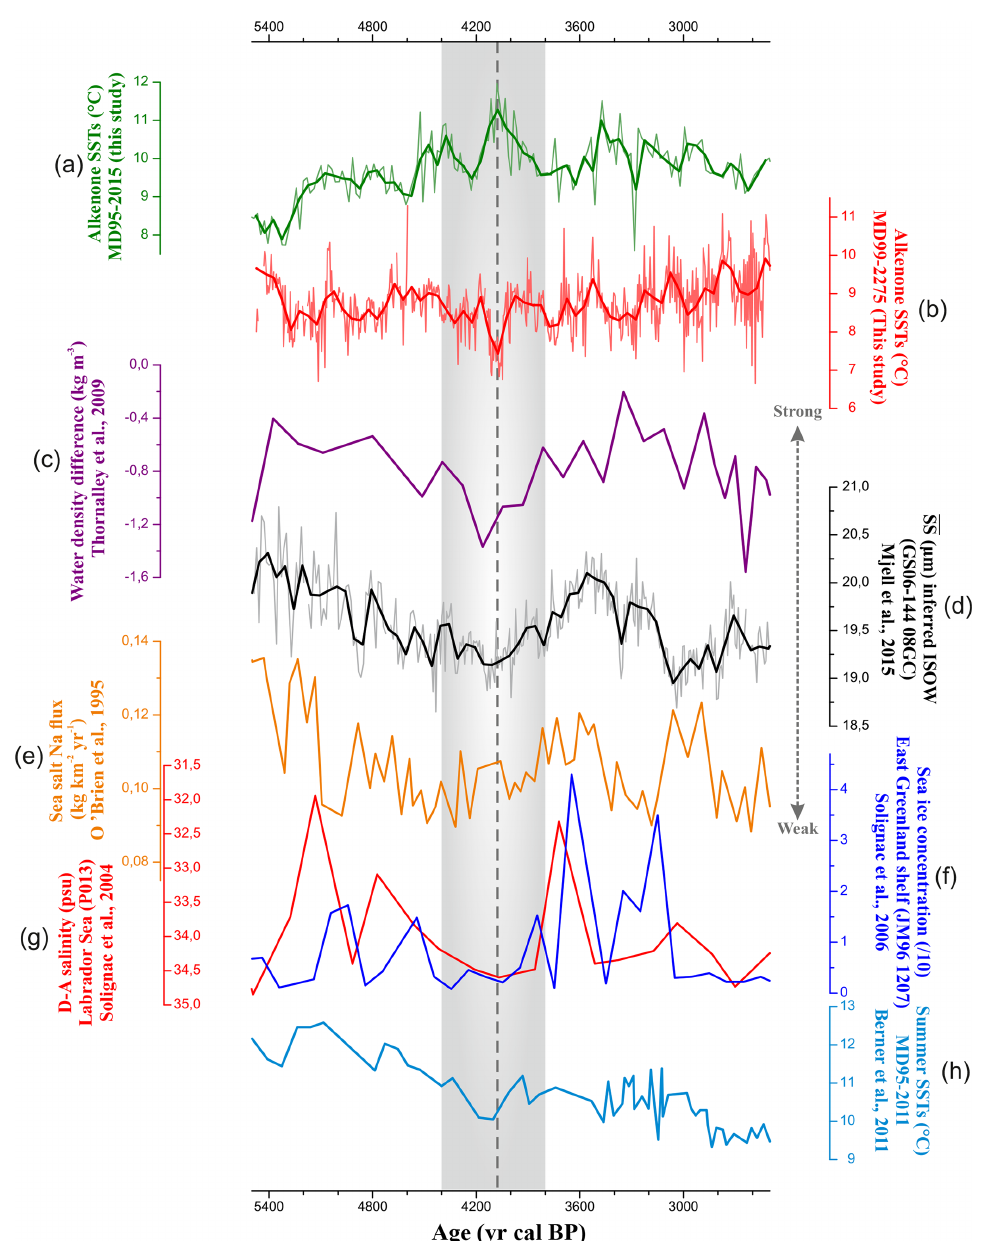
Figure 3. Paleoclimatic and paleo-oceanographic data from the North Atlantic during the 4.2kaBP event. (a) Alkenone-derived SSTs at the MD95-2015 core. (b) Alkenone-derived SSTs at the MD99-2275 core. (c) Density difference between surface and subsurface waters obtained from paired Mg/Ca and δ 18 O in Globigerina bulloides and Globorotalia inflata in core RAPiD-12-1K (site 4 in Fig. 1) (Thornalley et al., 2009). (d) Mean sortable silt (SS, 10–63µm) in core GS06-144 08GC in the Iceland Basin (site 3, Fig. 1) (Mjell et al., 2015). (e) Sea salt Na flux from the GISP2 ice core (site 7, Fig. 1) (O’Brien et al., 1995). (f) Sea ice concentration from the East Greenland shelf based on dinoflagellate cyst assemblages in core JM96 1207 (site 6, Fig. 1) (Solignac et al., 2006). (g) Dinoflagellate cyst-assemblage-inferred sea surface salinity from the Labrador Sea core P-013 (site 5, Fig. 1) (Solignac et al., 2004). (h) Summer SSTs derived from diatom-based weighted averaging partial least squares transfer function from core MD95-2011 (site 9, Fig. 1) (Berner et al., 2011). For panels (a) , (b) and (d) 50-year binning is applied to reduce the effect of proxy reconstruction error (thick lines). This binning has not been applied to the low temporal-resolution records. The grey vertical band represents the 4.2kaBP event time interval (4400–3800calBP). The dashed line highlights the 4100calBP where extrema are seen in most